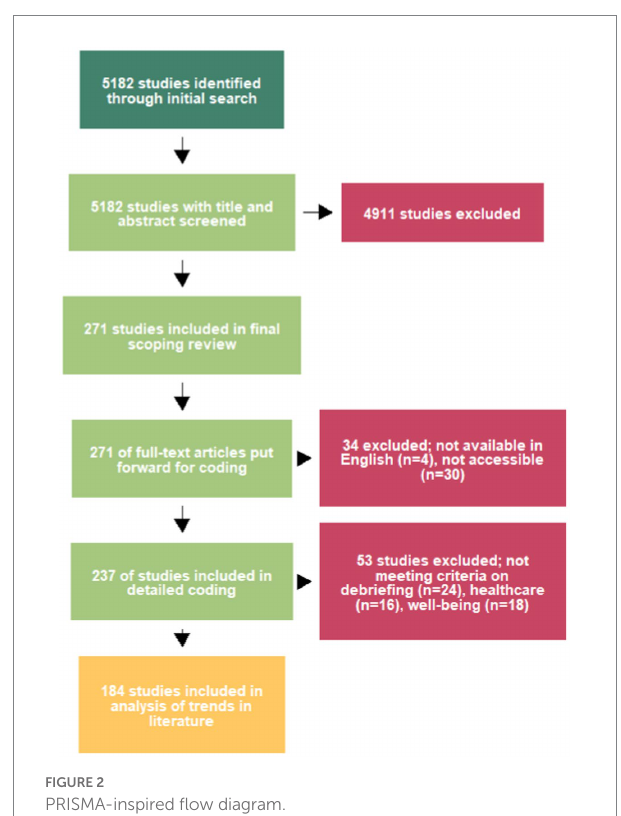
FIGURE 2 PRISMA-inspired flow